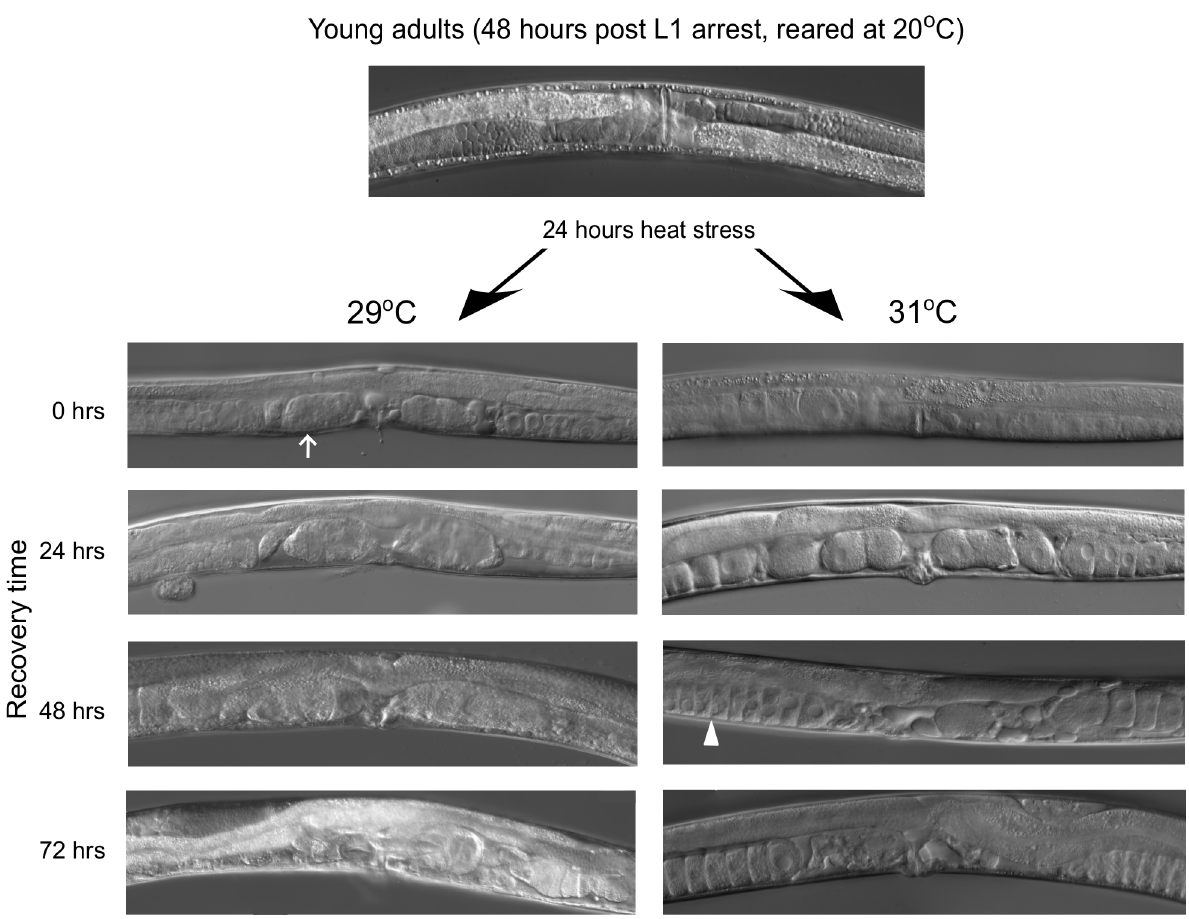
Figure 3. Reproduction-related defects following chronic heat stress. Representative images of worms at 0, 24, 48 and 72 hours of recovery from a 24-hour stress either at 29 u C or 31 u C are shown. An arrow points to uterine concretions and an arrowhead to stacked oocytes. In all pictures, anterior is to the left and ventral is down. doi:10.1371/journal.pone.0105513.g003 PLOS ONE |